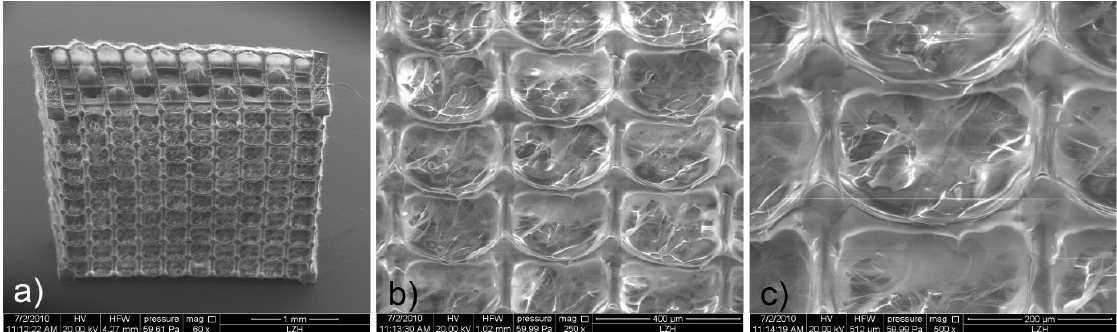
Figure 2. SEM images of the 2PP-produced gelatin scaffolds: ( a ) an overview image; ( b, c ) magnified images showing that the scaffold pores are filled with a fibrous